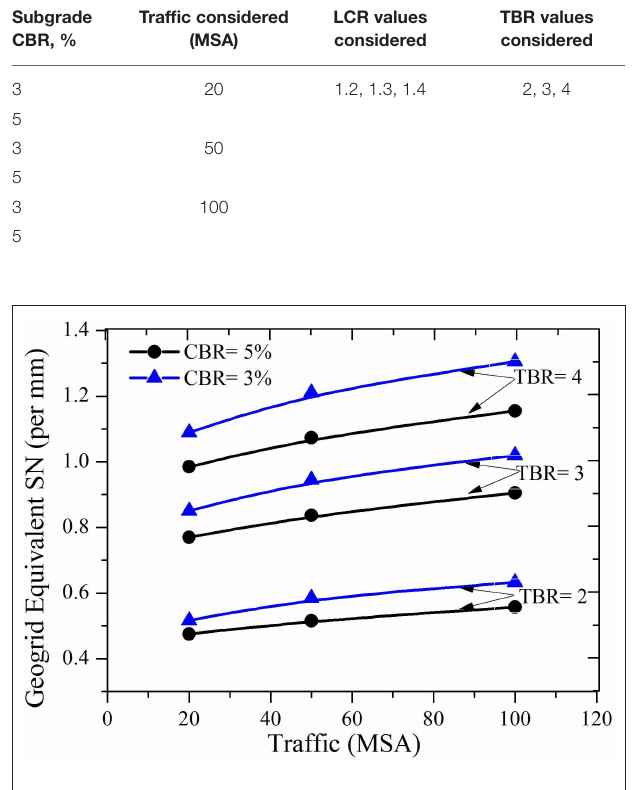
of 3 and 5% and three types of traffic (20, 30, and 100 MSA) were chosen to observe the changes in pavement